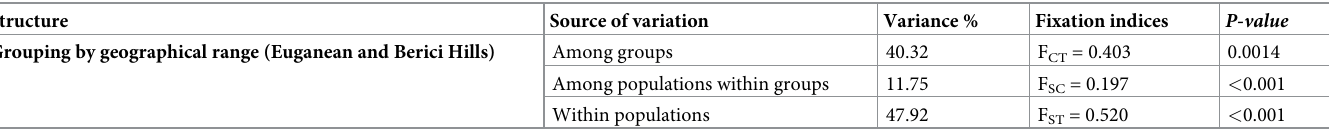
Table 2. Analysis of molecular variance AMOVA for the combined data set (COI-tRNALeu-COII and 12S-CR). Structure Source of variation Variance % Fixation indices P-value Grouping by geographical range (Euganean and Berici Hills) Among groups 40.32 F CT = 0.403 0.0014 Among populations within groups 11.75 F SC = 0.197 < 0.001 Within populations 47.92 F ST = 0.520 < 0.001 Amova was calculated among populations of Barbitistes vicetinus divided according to the outbreak